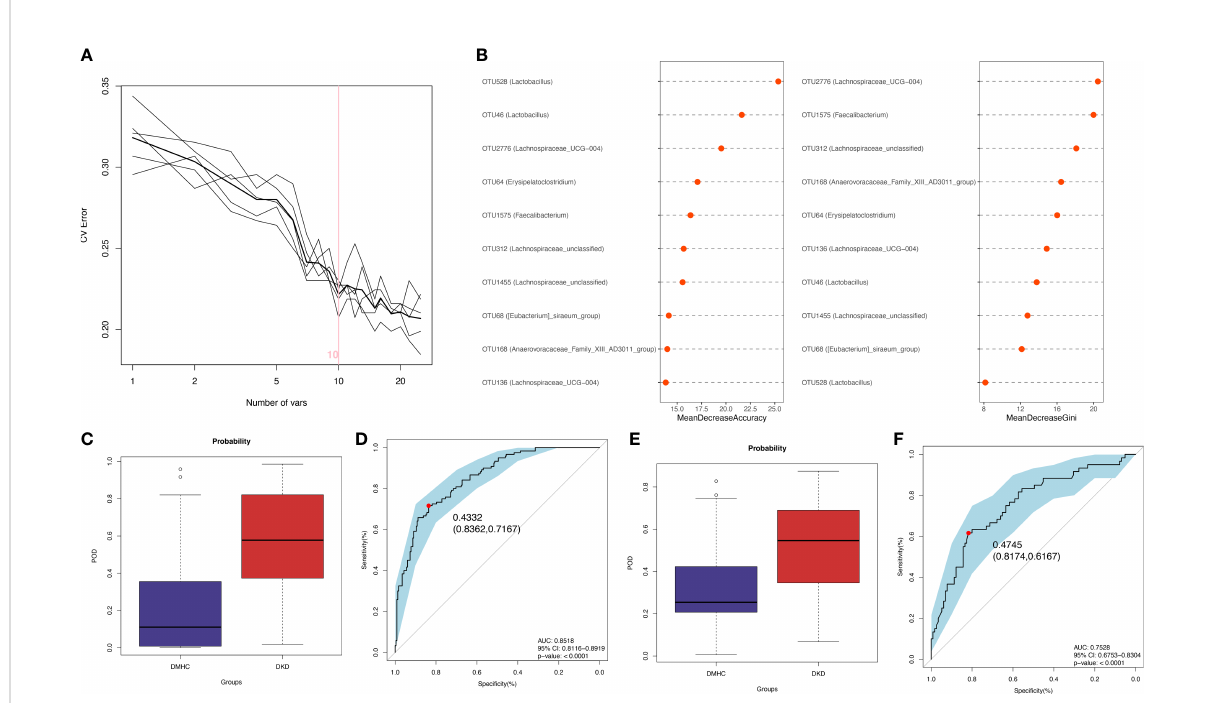
FIGURE 4 Diagnostic outcomes for DKD and non-DKD in discovery phase and validation phase. (A, B) Predictive performance of microbial combinations including different key OTU number (computed by 5-fold cross-validation and random forest). POD index in discovery phase (C) or validation phase (E) was used to estimate diagnostic ef fi ciency for DKD. Integrating fi vefold cross-validation with random forest model, ten microbial OTUs was identi fi ed as optimal diagnostic biomarkers. (D) ROC curve of the DKD-related classi fi er using 10 microbial biomarkers to distinguish 120 DKDs from 232 non-DKDs. (F) AUC in validation phase veri fi ed the predictive power of diagnostic model in 60 DKDs and 116 non-DKDs. Corresponding 95% CI and P value were shown in graph. CV, cross-validation; POD, possibility of disease; ROC, receiving operational curve; AUC, area under the curve; CI, con fi dence